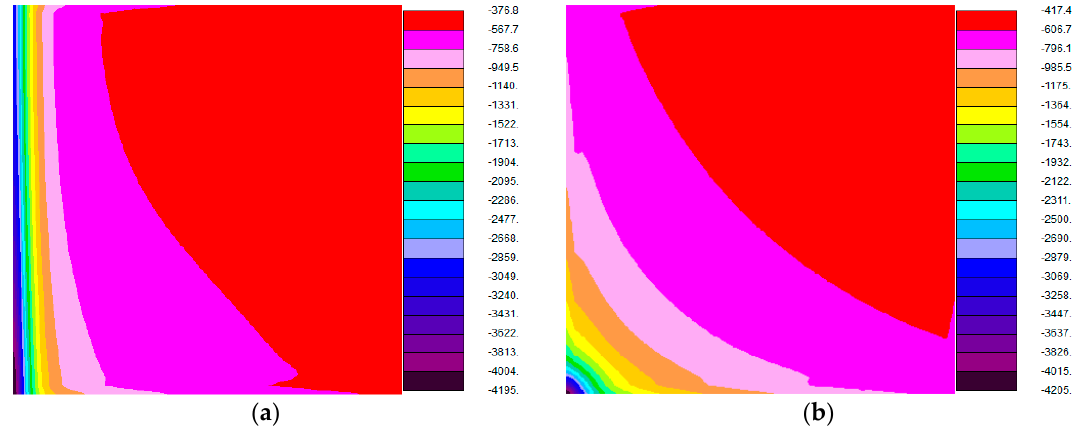
Figure 5. The plate hot side heat flux q h distributions of cross-flow plate heat exchanger ( a ) Heat transfer model with LHC; ( b ) Heat transfer model without LHC.